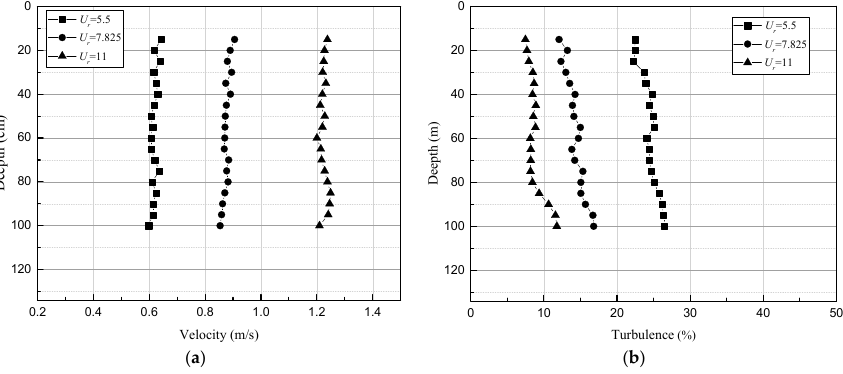
Figure 2. Incoming flow characteristics. ( a ) Velocity profile; ( b ) turbulence profile.